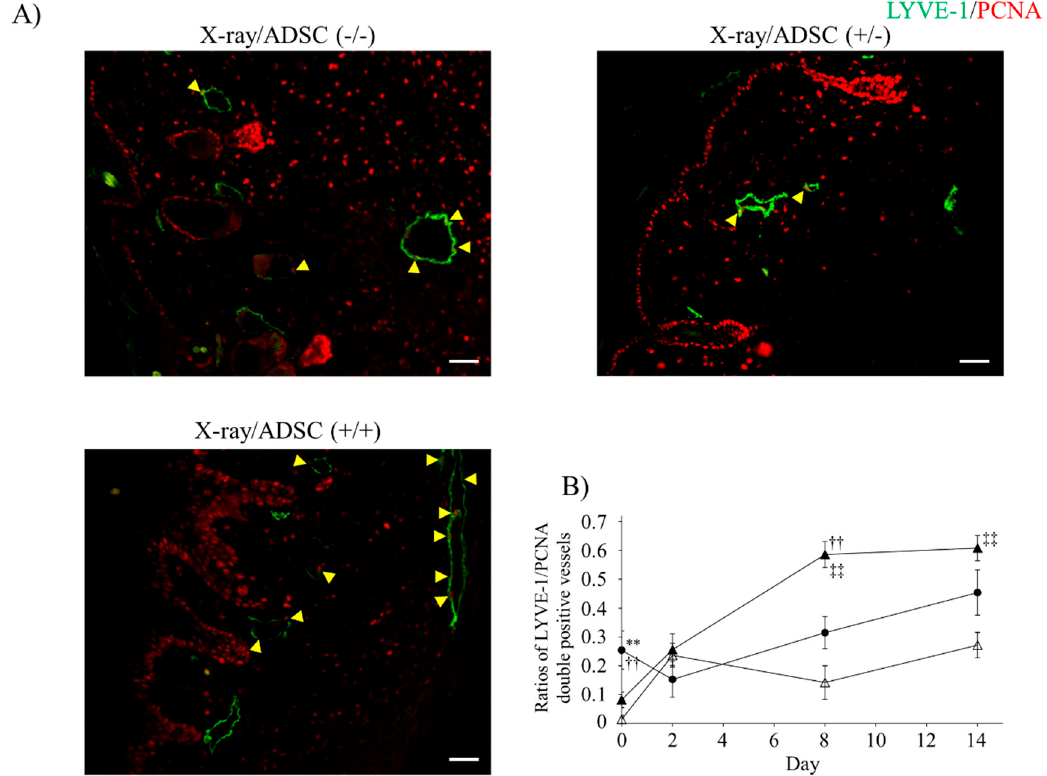
Figure 3. Ratios of proliferative lymphatic vessels with LYVE-1 and proliferating cell nuclear antigen (PCNA) immunoreactivity. ( A ) Representative images of immunofluorescence using anti-LYVE-1 (green) and anti-PCNA (red) antibody at day 8. Arrow heads: LYVE-1 and PCNA double-positive lymphatic endothelial cells. Scale bars (magnification): 50 µm (200×). ( B ) Ratio of proliferative lymphatic vessels (mean ± SE). Results of multiple comparisons within the same day groups are indicated. ** p < 0.01: significantly different between X-ray/ADSC ( − / − ) and X-ray/ADSC (+/ − ). †† p < 0.01: significantly different between X-ray/ADSC ( − / − ) and X-ray/ADSC (+/+). ‡‡ p < 0.01: significantly different between X-ray/ADSC (+/ − ) and X-ray/ADSC (+/+). Symbols represent each study group ( n = 3–6 mice/group): X-ray/ADSC ( − / − ) ( ● ), X-ray/ADSC (+/ − ) ( △ ), X-ray/ADSC (+/+) ( ▲ ). Rates of proliferative lymphatic vessels to all lymphatic vessels are shown in Figure 3B and Table 2. On day 0, the proliferative activity of the two X-ray ( + ) groups was significantly suppressed; lymphatic vessel dissection triggered the increased rates of proliferative lymphatic vessels. In the X-ray / ADSC ( +/+ ) group, the rates significantly increased on day 8 and persisted until day 14, but in the X-ray / ADSC ( − / − ) group, the increase was not